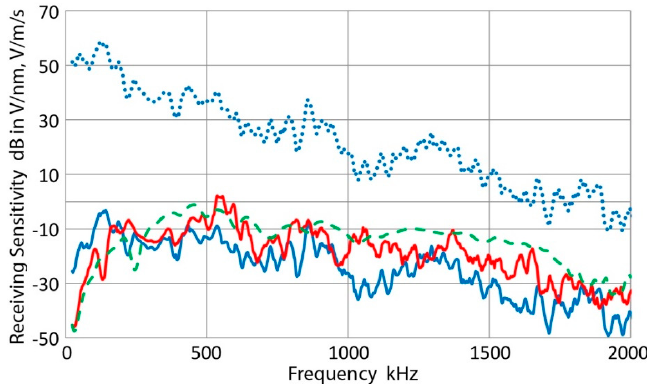
Figure 14. Receiving sensitivity of PAC Pico (3804). The displacement receiving sensitivities to bar waves are shown in solid blue curve for the present work and in red curve from the old data [8] (reproduced with permission from [8]. Copyright AE Group, 2010). Green curve is the displacement receiving sensitivity to normally incident waves [4]. The velocity sensitivity corresponding to the solid blue curve is given in dotted blue curve.